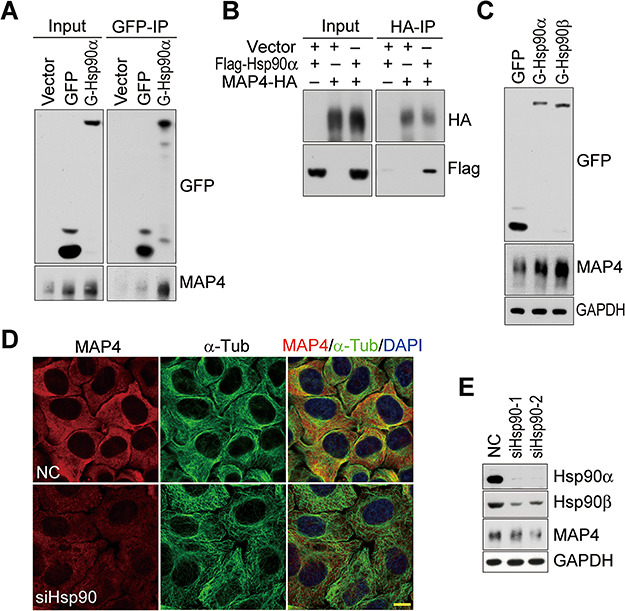
The identification of MAP4 as an Hsp90-interacting protein. (A) The interaction of MAP4 with Hsp90 in vivo. Stable HeLa cells expressing GFP or GFP-tagged Hsp90α were lysed and immunoprecipitated by anti-GFP affinity magnetic agarose. The immunoprecipitated samples were blotted for MAP4. (B) Interaction between exogenous Flag-tagged Hsp90α and HA-tagged MAP4 in HEK293T cells. Flag-tagged Hsp90α and HA-tagged MAP4 were co-expressed in HEK293T cells and MAP4 was immunoprecipitated by anti-HA affinity gel. The immunoprecipitated samples were detected for Flag-tagged Hsp90α by western blot. (C) Increase of MAP4 protein in Hsp90-overexpressed cells. HeLa cells stably expressing GFP or GFP-tagged Hsp90α or Hsp90β were lysed and equal amounts of proteins were loaded to detect MAP4 level by western bolt. GAPDH is the protein loading control. (D and E) Reduction of MAP4 in Hsp90-depleted HeLa cells detected by immunofluorescence (D) and western blot (E). Scale bar, 10 μm.